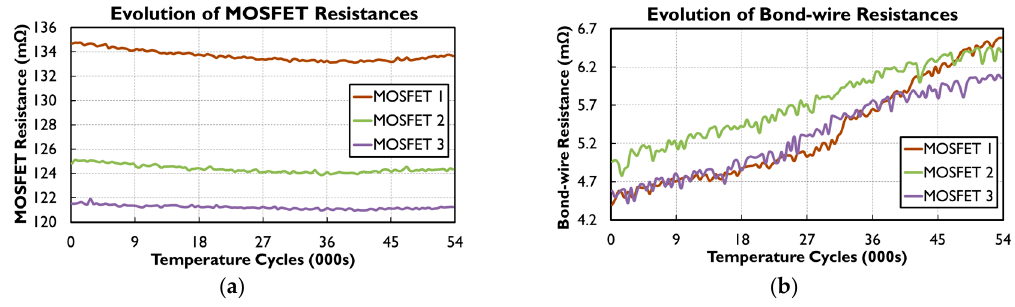
Figure 7. ( a ) Evolution of MOSFET resistances throughout the power cycling test; ( b ) Evolution of bond-wire resistances throughout the power cycling test.